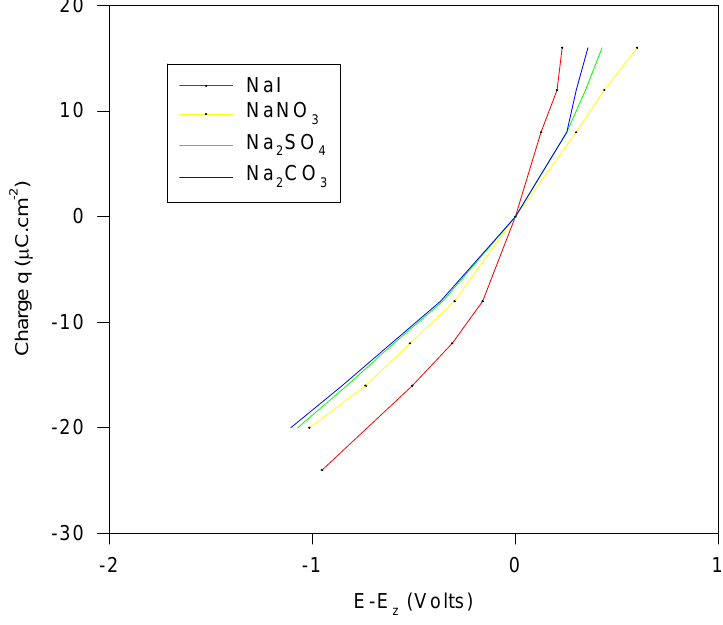
Figure 4. Charge on Hg in contact with 1M electrolytes at 25